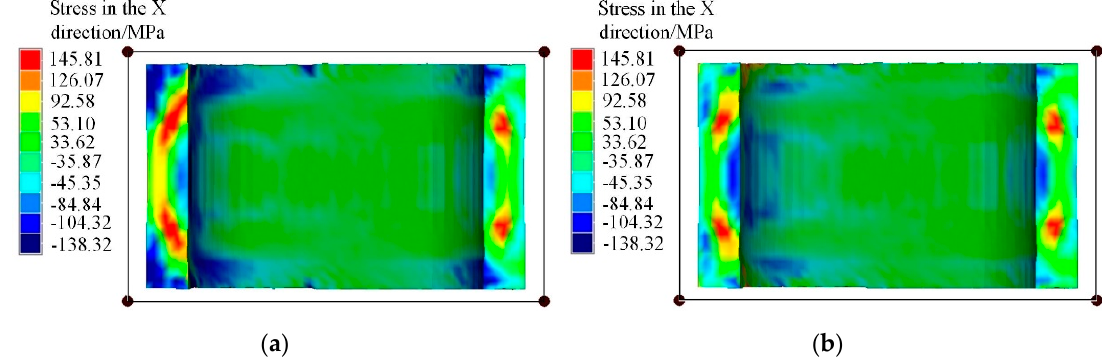
Figure8. Simulationresultsofresidual-stresshomogenization. ( a )Beforeexpansion; ( b Figure 8. Simulation results of residual ‐ stress homogenization. ( a ) Before expansion; ( b ) after expansion.